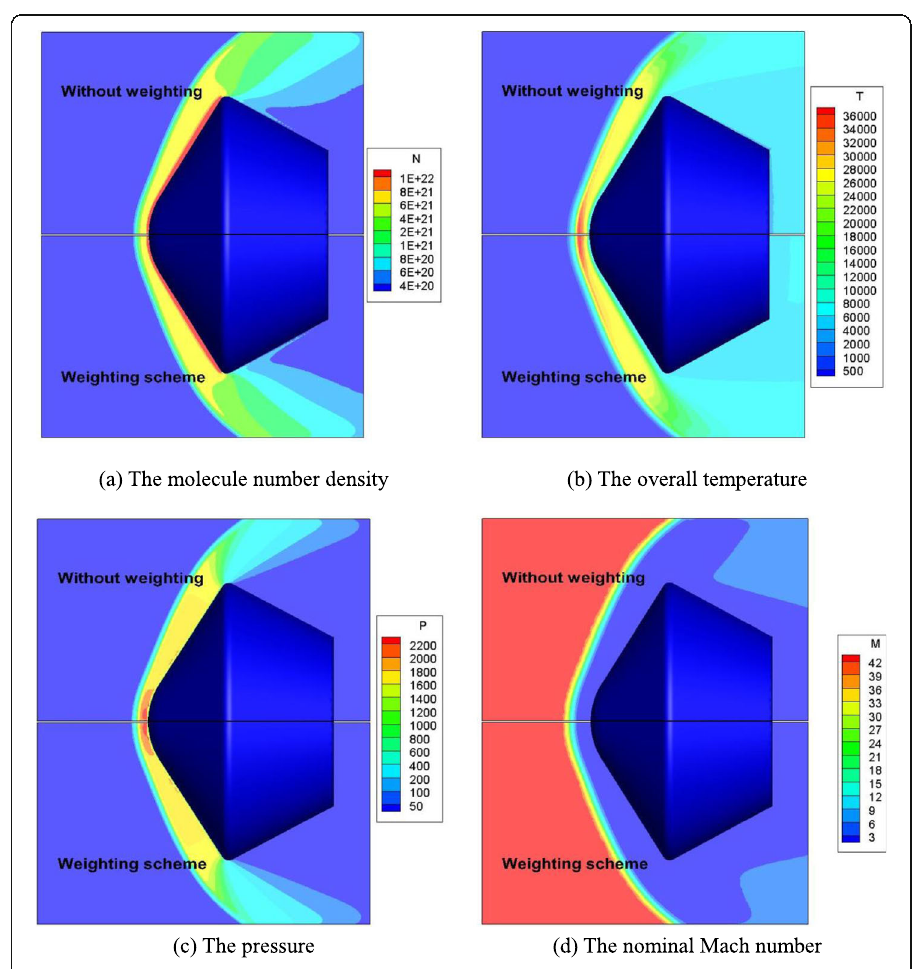
Fig. 11 The distribution of flowfield macroscopic variables around Stardust at H = 80km, V ∞ = 12.8 k m/s. a The molecule number density. b The overall temperature. c The pressure. d The nominal Mach